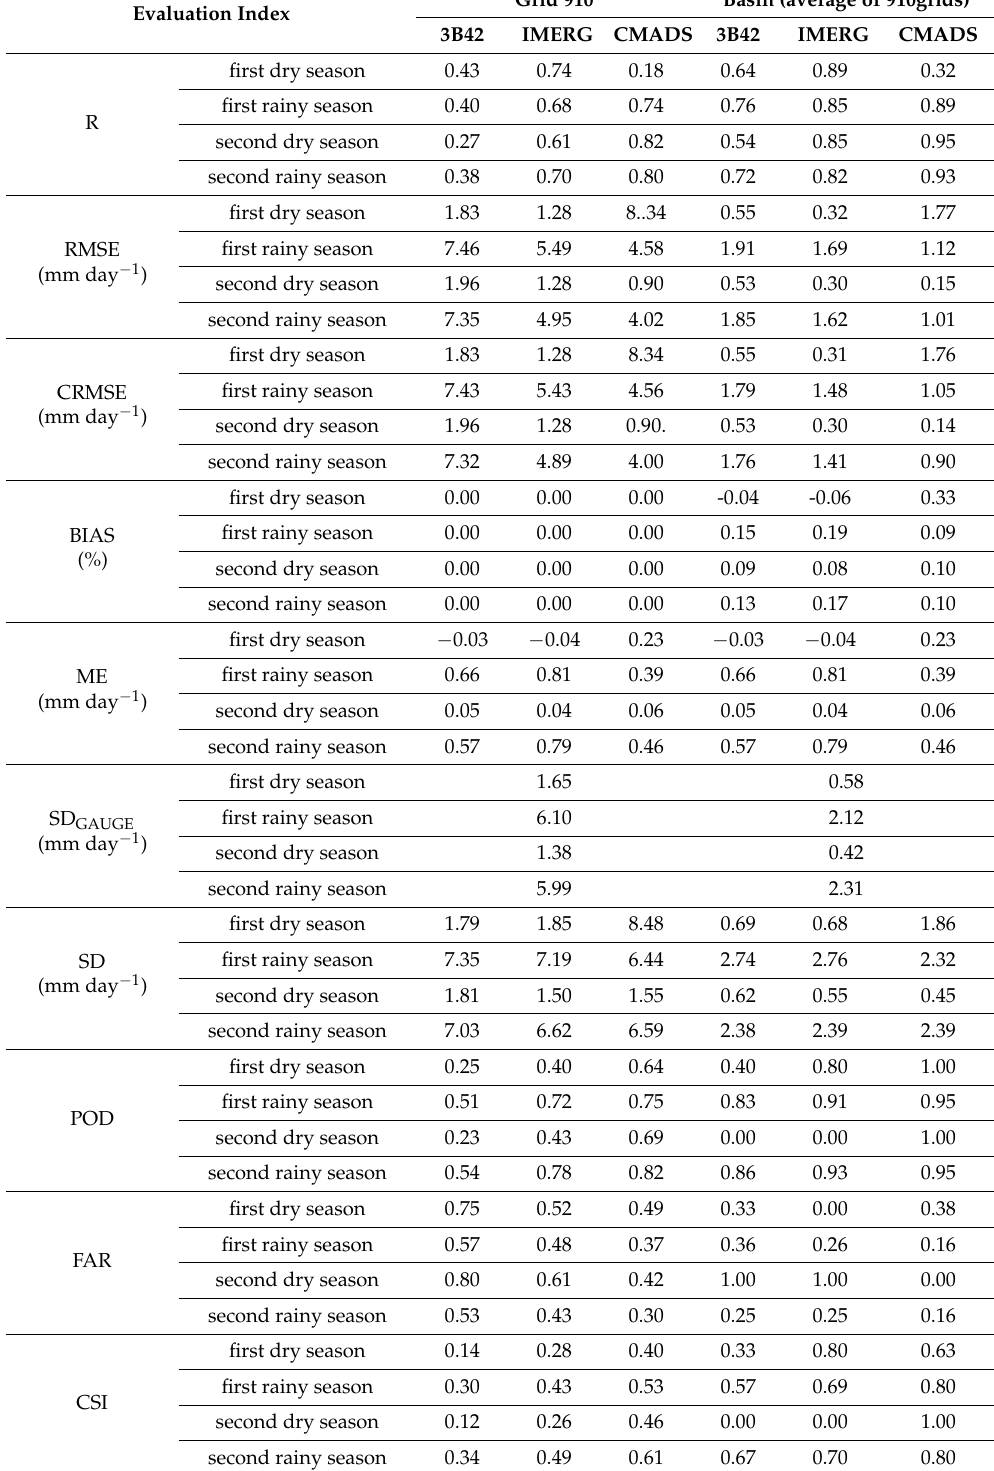
Table 3. Error markers (markers related to the dry season and rainy